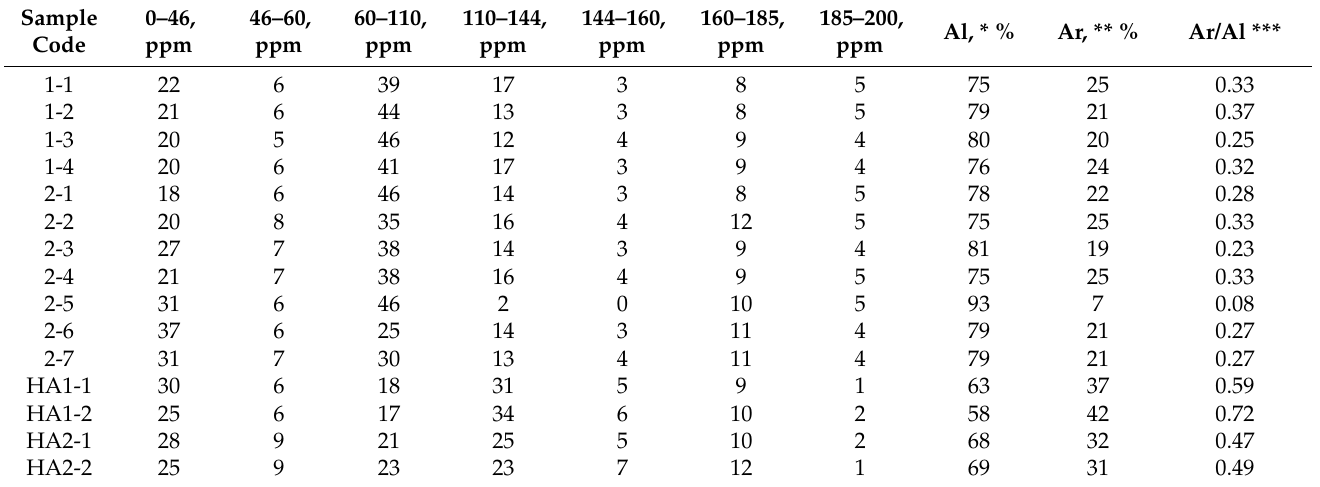
Table 4. Carbon species in organic molecules according to the 13C NMR